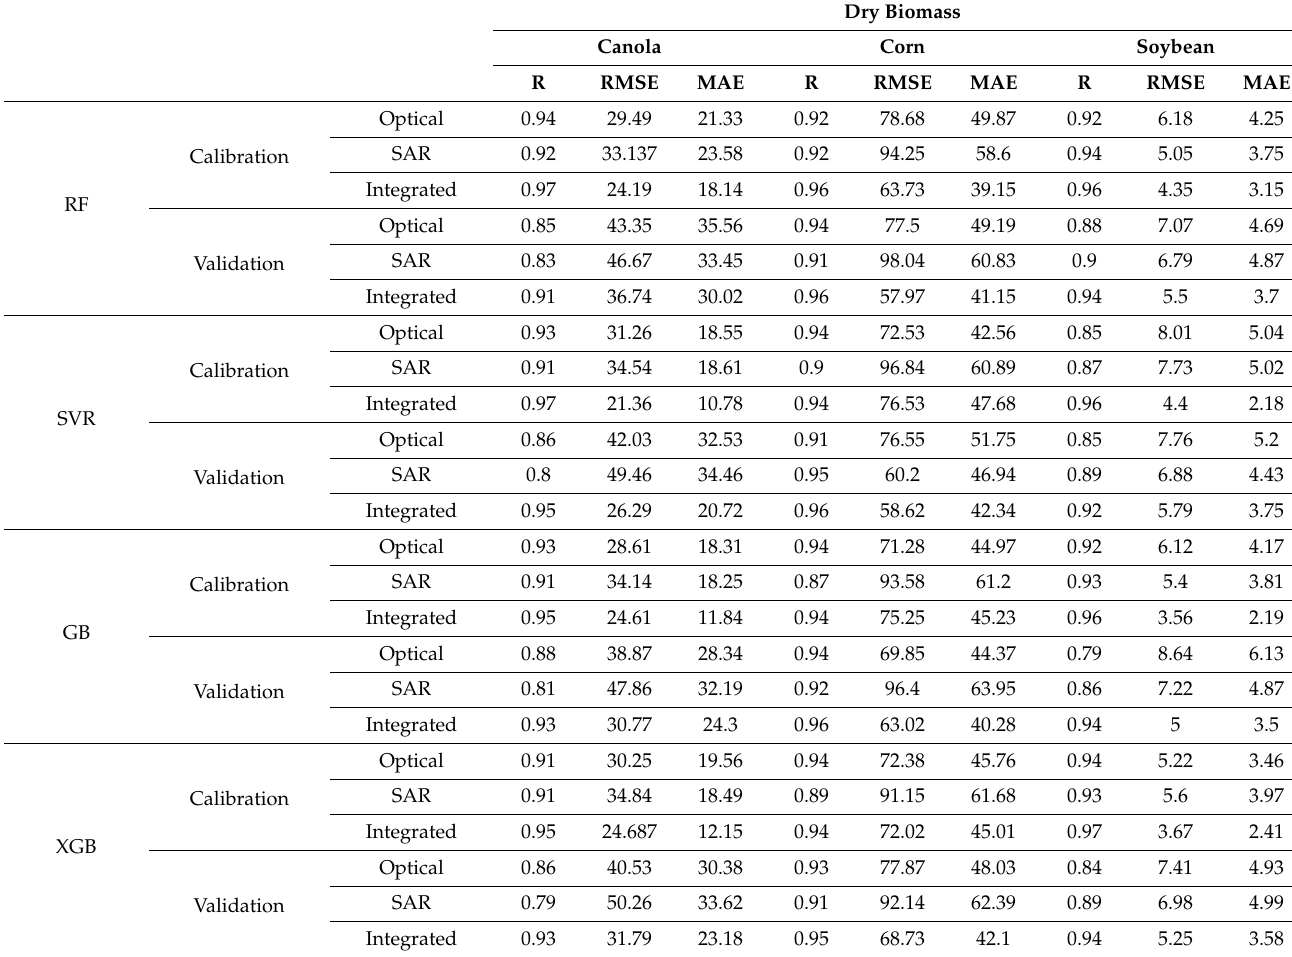
Table 8. Results of four MLAs in estimating dry biomass.